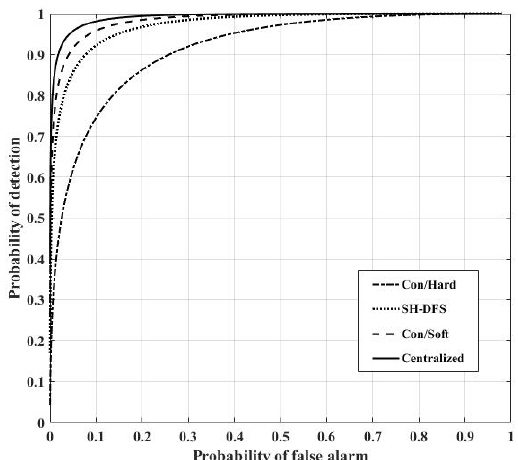
Figure 13. The probability of detection of four different methods versus the global desired probability of false alarm at the FC.